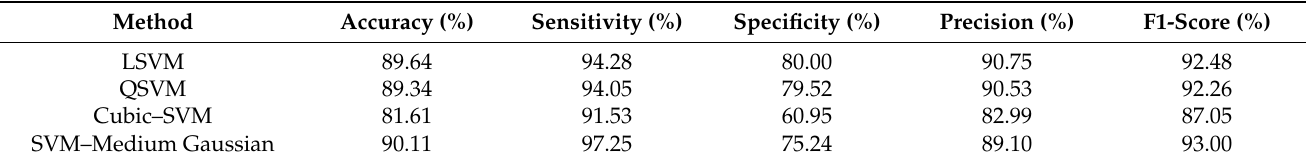
Table 8. CNN activated feature-based classification using 10-fold